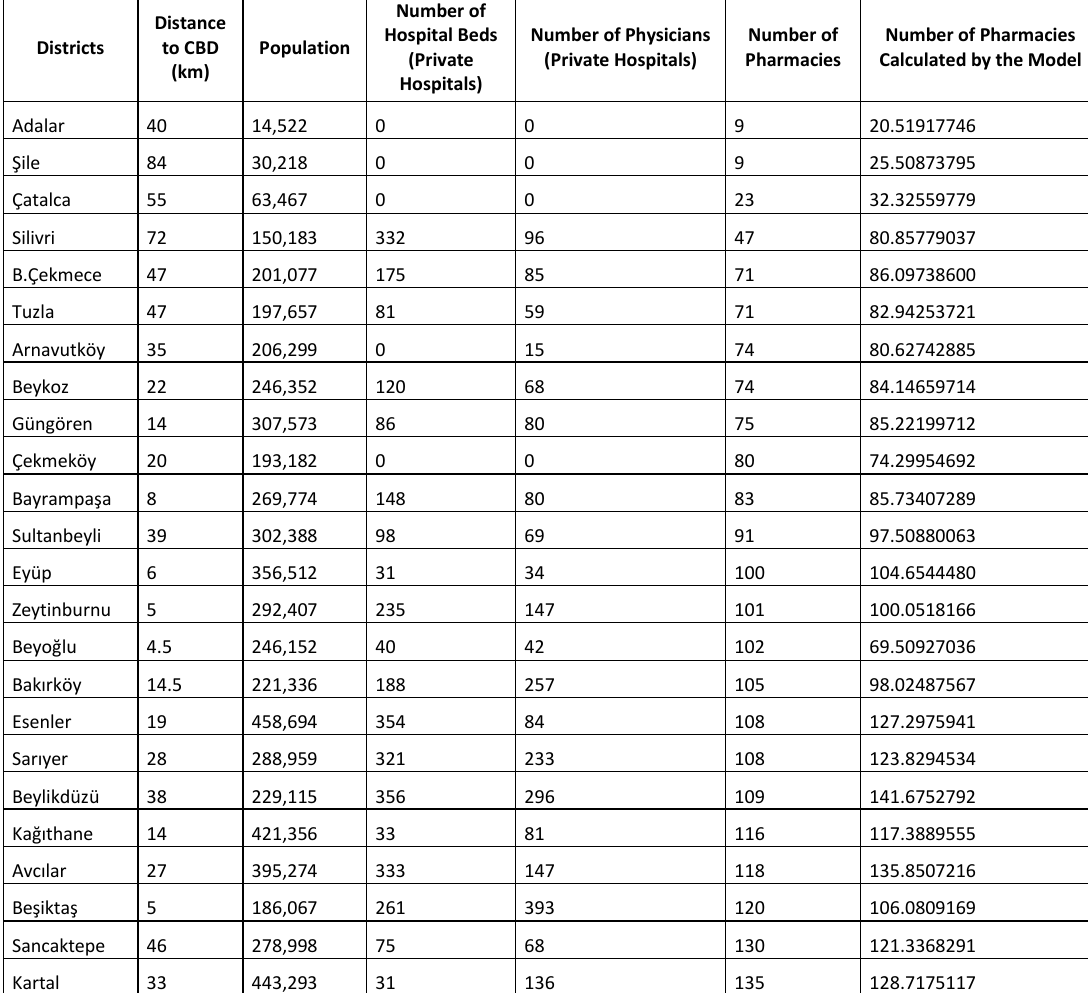
Table 1 Population and the number of pharmacies, hospital beds and physicians in the districts in